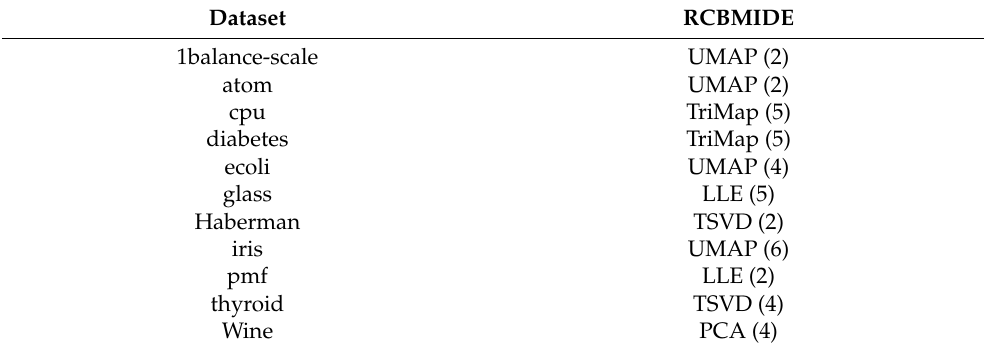
Table A2. RCBMIDE method extension (dimensionality reduction) for each lower-dimensions